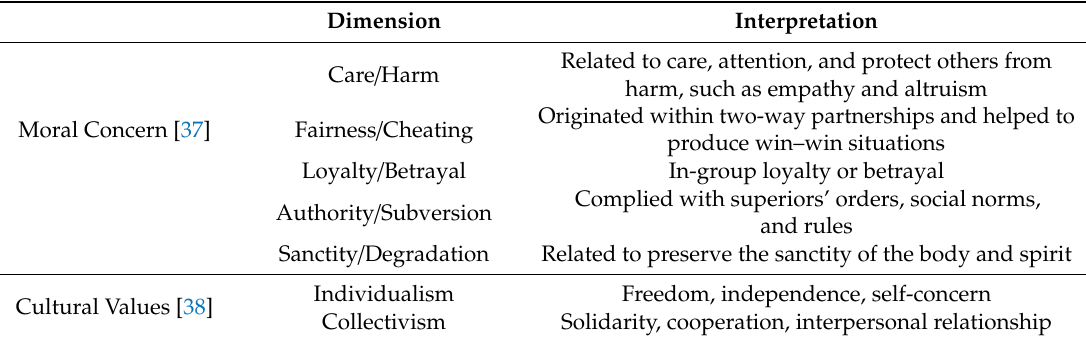
Table 2. The interpretation of moral concern and cultural values